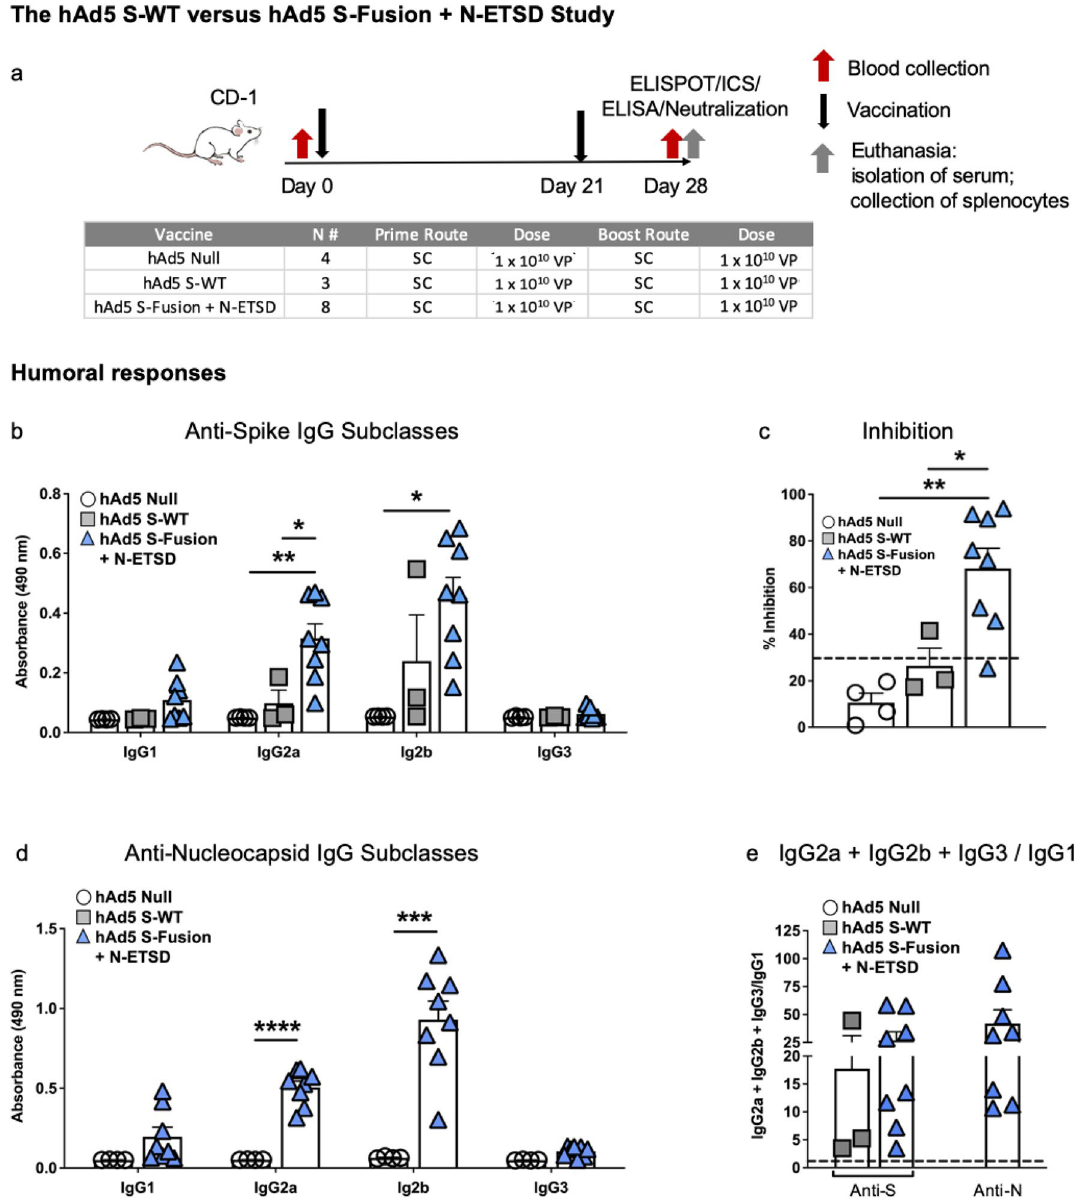
Figure 2. Humoral responses to S are higher for S‑Fusion as compared to S‑WT . ( a ) CD-1 mice received hAd5 Null (n = 4), hAd5 S-WT (n = 3), or the hAd5 S-Fusion + N-ETSD vaccine (n = 8) on Day 0 and Day 21 by subcutaneous (SC) injection and were euthanized for tissue collection on Day 28. ( b ) Anti-S antibody levels in sera by subclass are shown (dilution 1:30) and are higher for S-Fusion + N-ETSD than S-WT. ( c ) Greater inhibition of ACE2: S RBD binding in the surrogate virus neutralization assay was also seen for S-Fusion + N-ETSD as compared to S-WT. Inhibition of 30% (dashed line) or greater is associated with live virus neutralization. ( d ) Anti-nucleocapsid (N) antibody levels (dilution 1:90) by subclass are shown for S-Fusion + N-ETSD only. ( e ) The IgG2a + IgG2b + IgG3/IgG1 ratio calculated using IgG ng equivalents reveals the T helper cell 1 (Th1) bias (> 1, dashed line) for all antibody responses. Statistics performed using one-way Analysis of Variance (ANOVA) with Dunnett’s post-hoc comparison of the S-Fusion + N-ETSD group to S-WT or Null, where * p < 0.05, ** p ≤ 0.01, *** p ≤ 0.001, and **** p ≤ 0.0001. Data graphed as the mean with